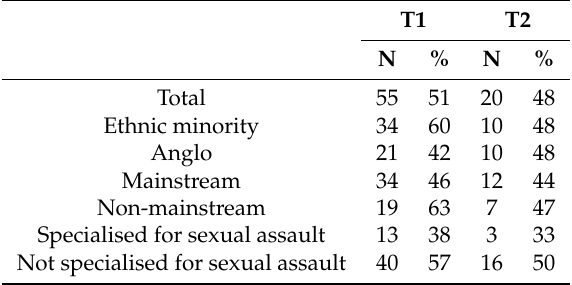
Table 5. Frequency data on client choice regarding ethnic